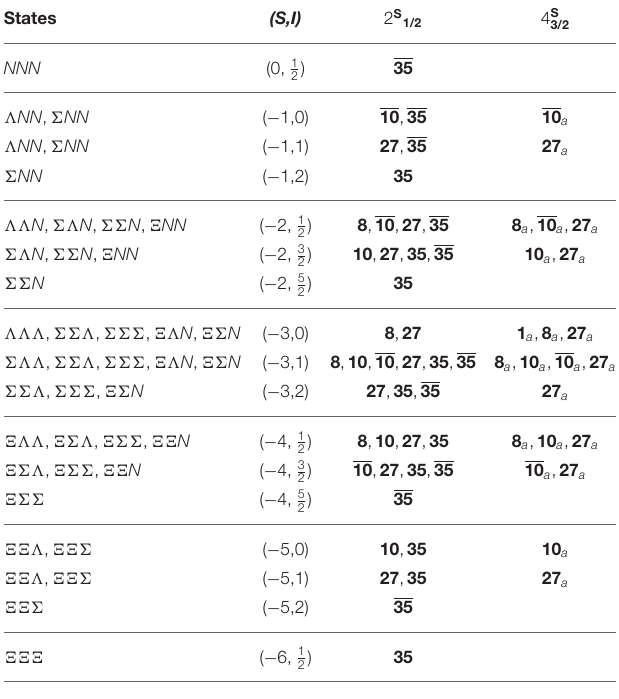
1 , 3 , the angular 2 2 = 1 , 3 2 2 =